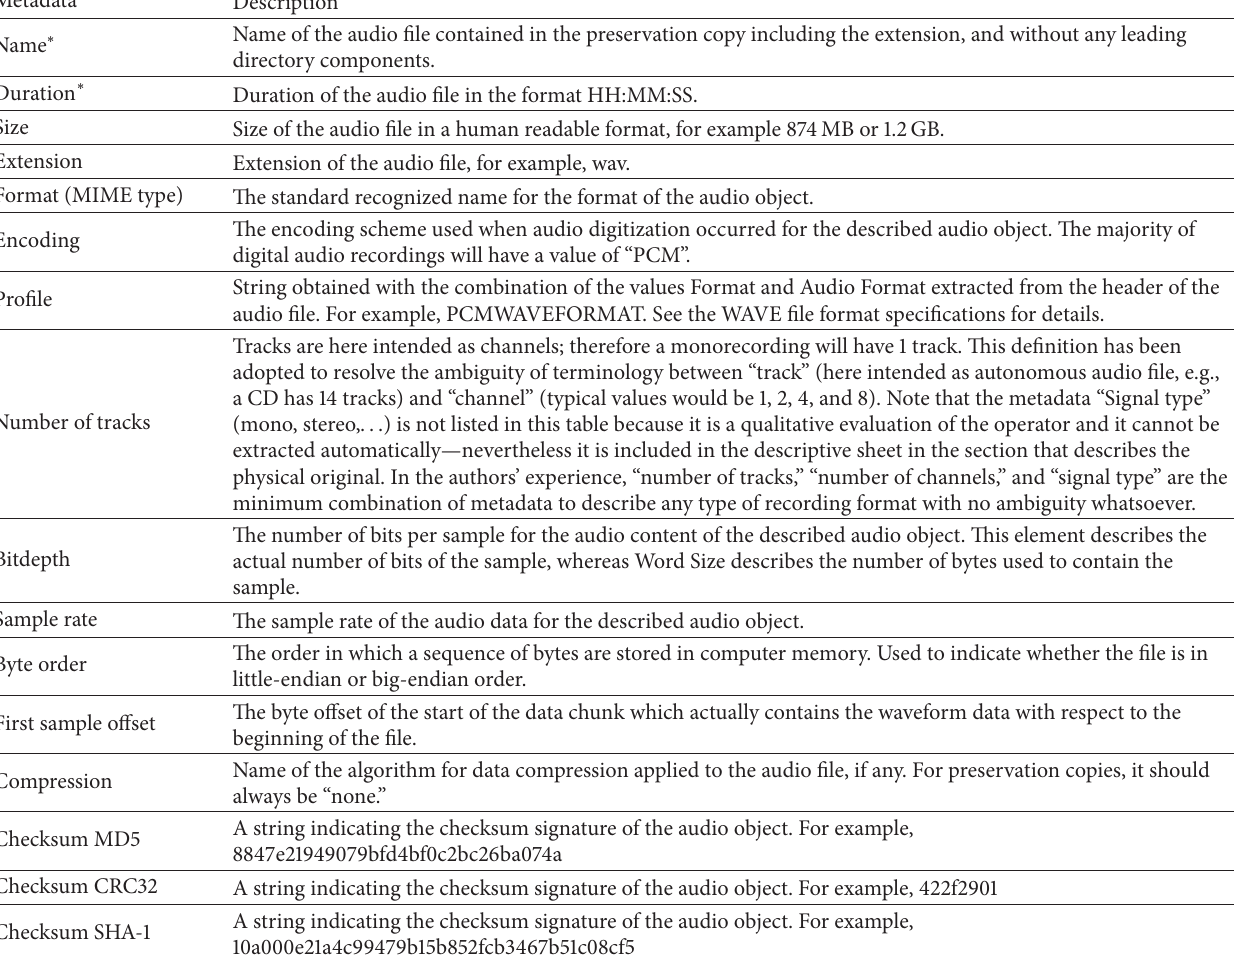
Table7:Metadataassociatedtotheaudiofilesinthedescriptivesheetofapreservationcopy.Itemsmarkedwithastar( ∗ )arenotobtainedwith JHove: the name of the file is given by the user, and the duration of the file is calculated with PSKit PreservationPanel (class